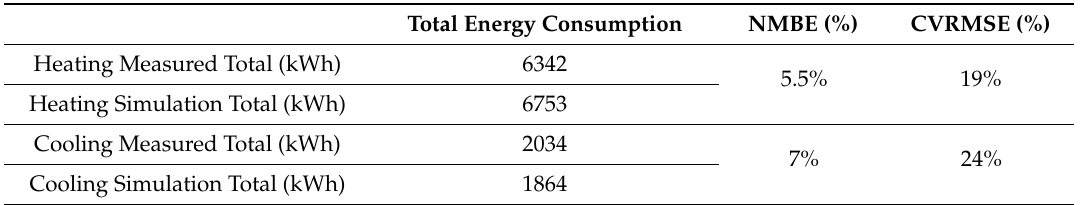
Table 4. Calibration results of the simulation